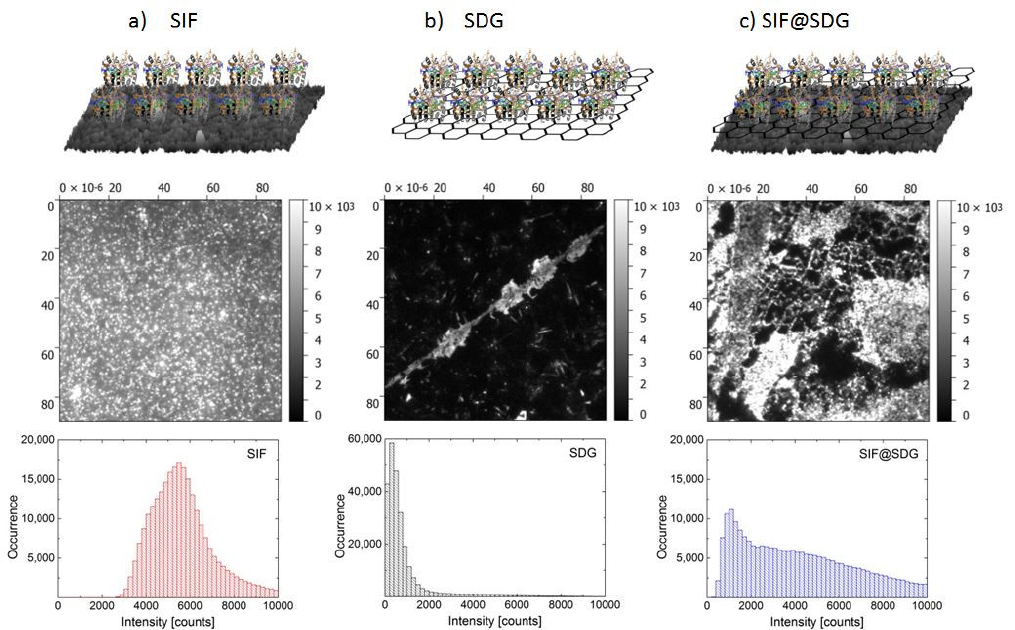
Figure 1. Fluorescence imaging of three studied structures composed of PCP complexes deposited on ( a ) Silver Island Film on glass; ( b ) Single-Double layer graphene on glass; and ( c ) Single-Double layer graphene transferred on Silver Island Film. For each structure we show a typical fluorescence map and corresponding intensity histogram obtained with the excitation at 480 nm. The intensity scale is the same for all fluorescence images.